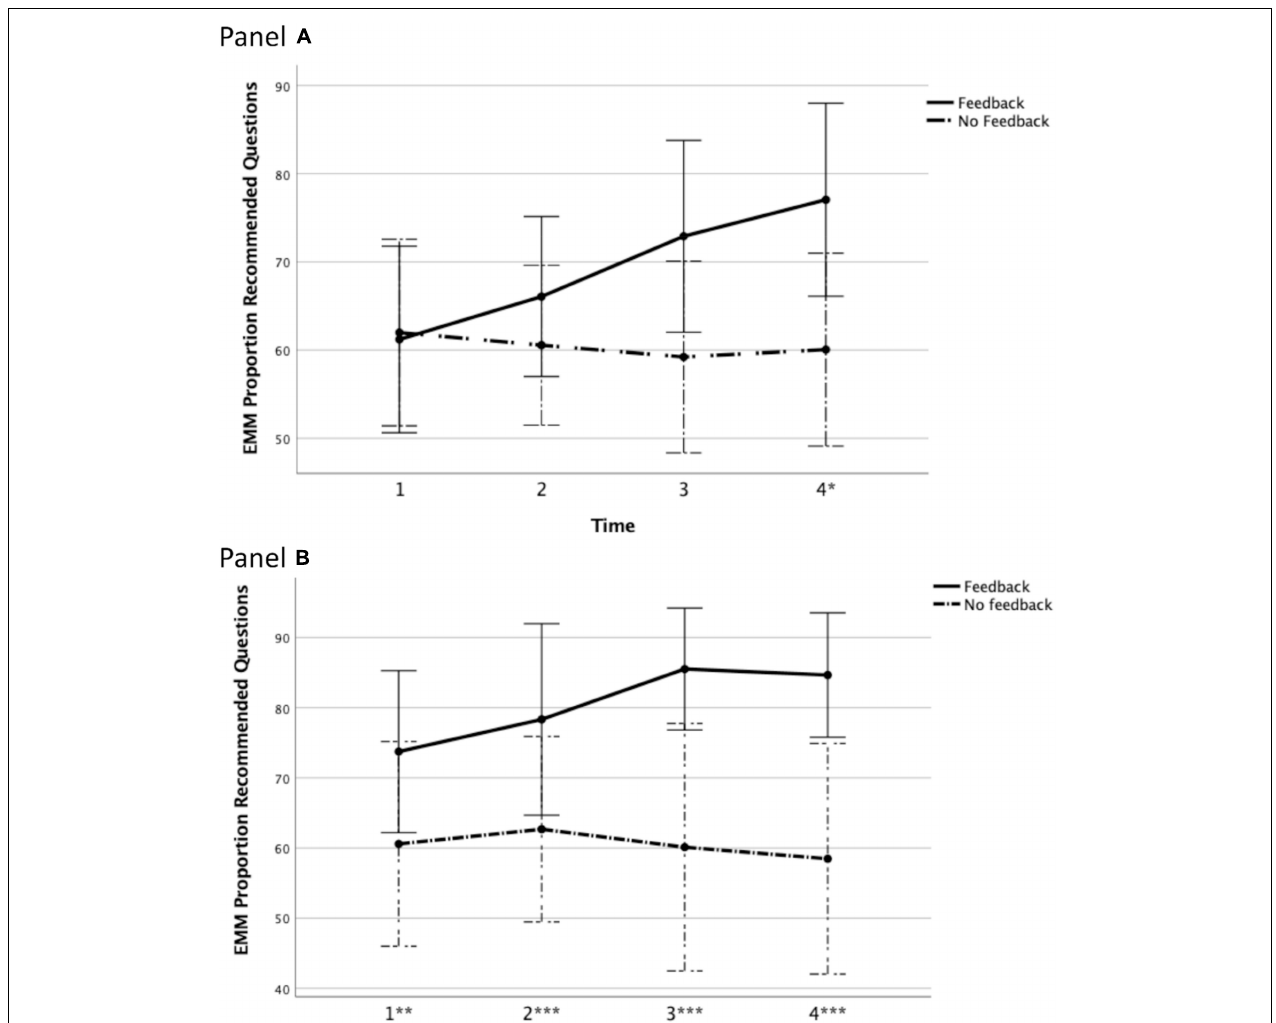
FIGURE 2 | Effects of feedback on proportion of recommended questions during the avatar training interviews. (A) Estimated marginal means (EMM) of the difference in initial four interviews between Group A ( n = 11; received feedback) and Group B ( n = 11; did not receive feedback). (B) Difference in Group B’s initial four interviews ( n = 9; did not receive feedback) and subsequent four interviews ( n = 9; received feedback). *Significant pairwise difference between conditions at the indicated interview. Error bars show 95% confidence intervals. Bonferroni correction applied * p < 0.05, ** p < 0.01, *** p < 0.001 (2-tailed).